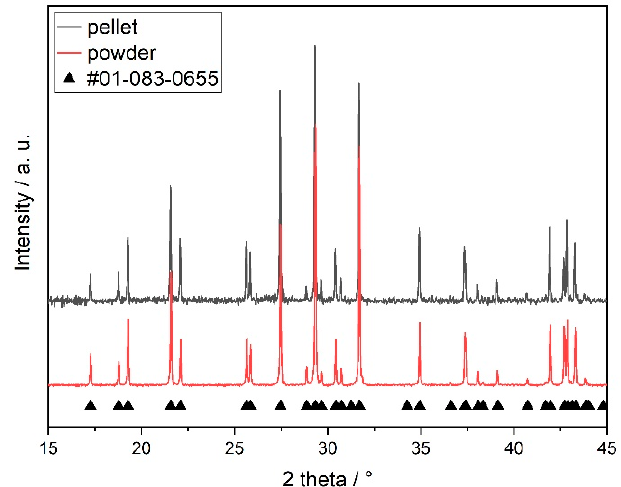
Figure 2. Powder diffraction patterns with normalised intensities of monazite-structured SmPO 4 powder and pellet samples in comparison to crystal structure data reported by Ni et al. (PDF no. 01-083-0655)